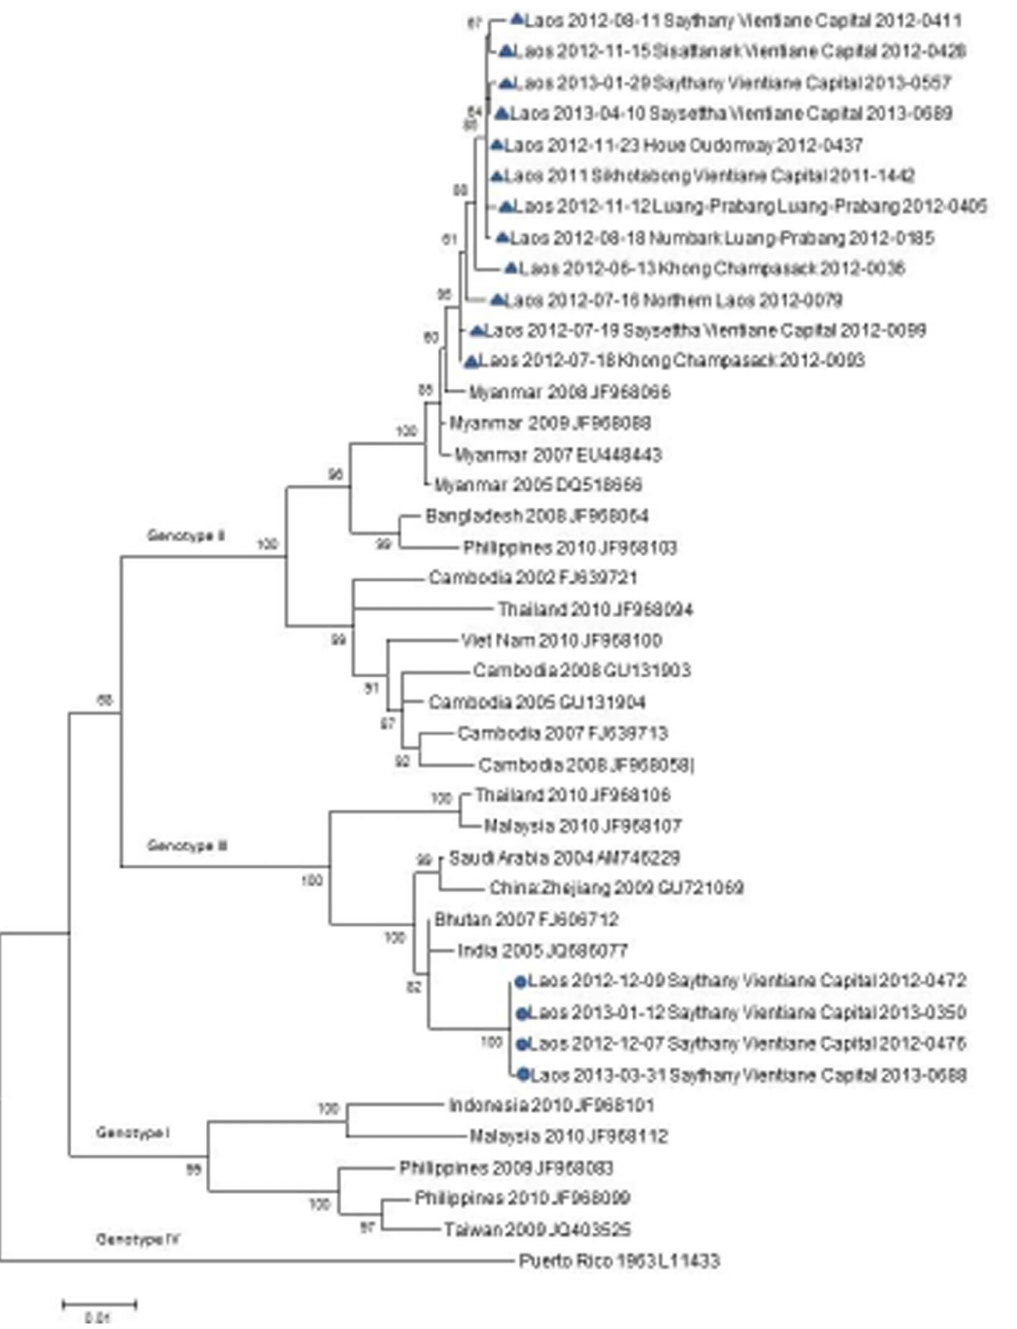
Fig. 2. Phylogenetic relationships of DENV-3 based on the complete E nucleotide sequences (1479 nt) of 41 isolates, including 16 Lao isolates. Blue triangles and blue circles represent Lao DENV-3 genotype II and III strains respectively. Sequence alignments were performed using BioNumerics version 6.6. A maximum-Likelihood tree was constructed using MEGA version 6, based on Tamura-Nei model. Bootstrap resampling values are indicated at major nodes. Scale bar indicates number of base substitutions per site.